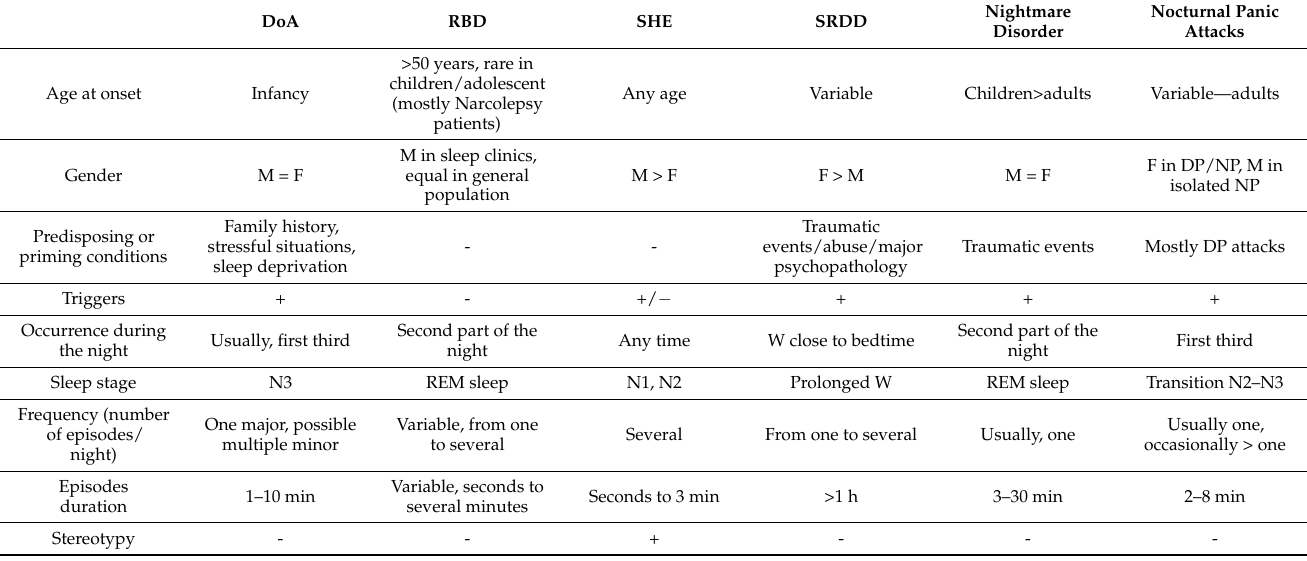
Table 6. DoA differential